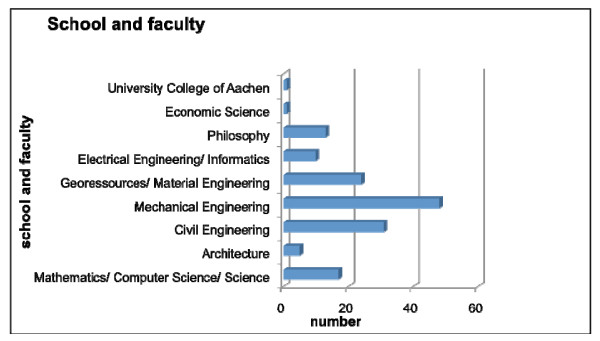
Participant's classification with regard to school and faculty. Data are total numbers.